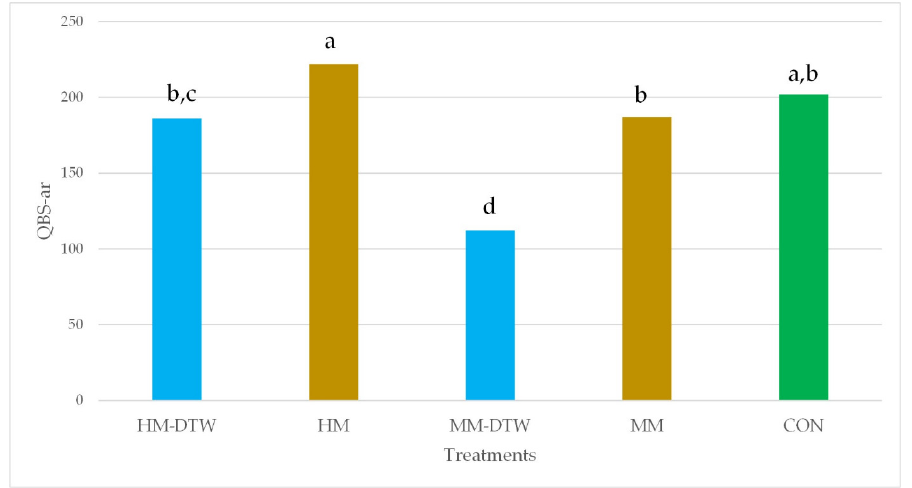
Figure 5. QBS-ar index for the different treatments. Obtained p -value from Kruskal–Wallis test was p = 0.0013. Different letters indicate homogeneous groups ( p < 0.05) according to Duncan test (HM-